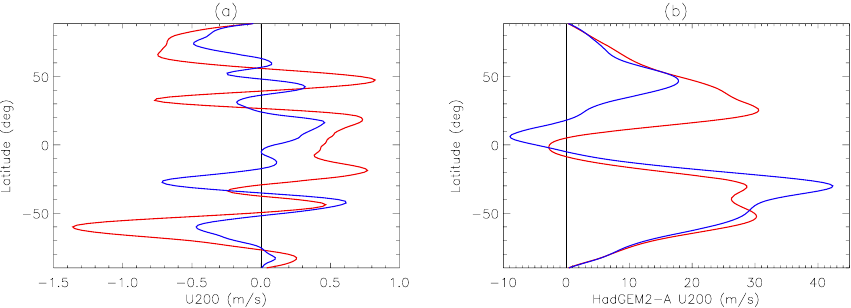
Fig. 12. Zonal mean horizontal westerly wind at 200hPa (ms − 1 ) in MAM (red) and JJA (blue): (a) differences between runs with and without land cover from HadGEM2-ES (no dust radiative effects); (b) actual wind in HadGEM2-A (no dust radiative effects).